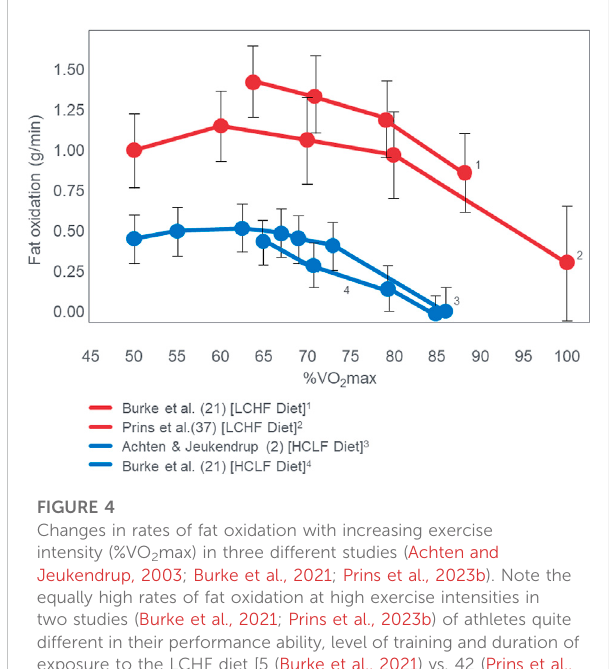
FIGURE 5 Distribution of Respiratory Exchange Ratios (RER) at rest in 61 subjects in the study of Goedecke et al. (Goedecke et al., 2000). Note that the mean RER at rest was 0.817 indicating that ~37% of the resting energy expenditure was derived from carbohydrate oxidation. Reproduced from (Goedecke et al., 2000).